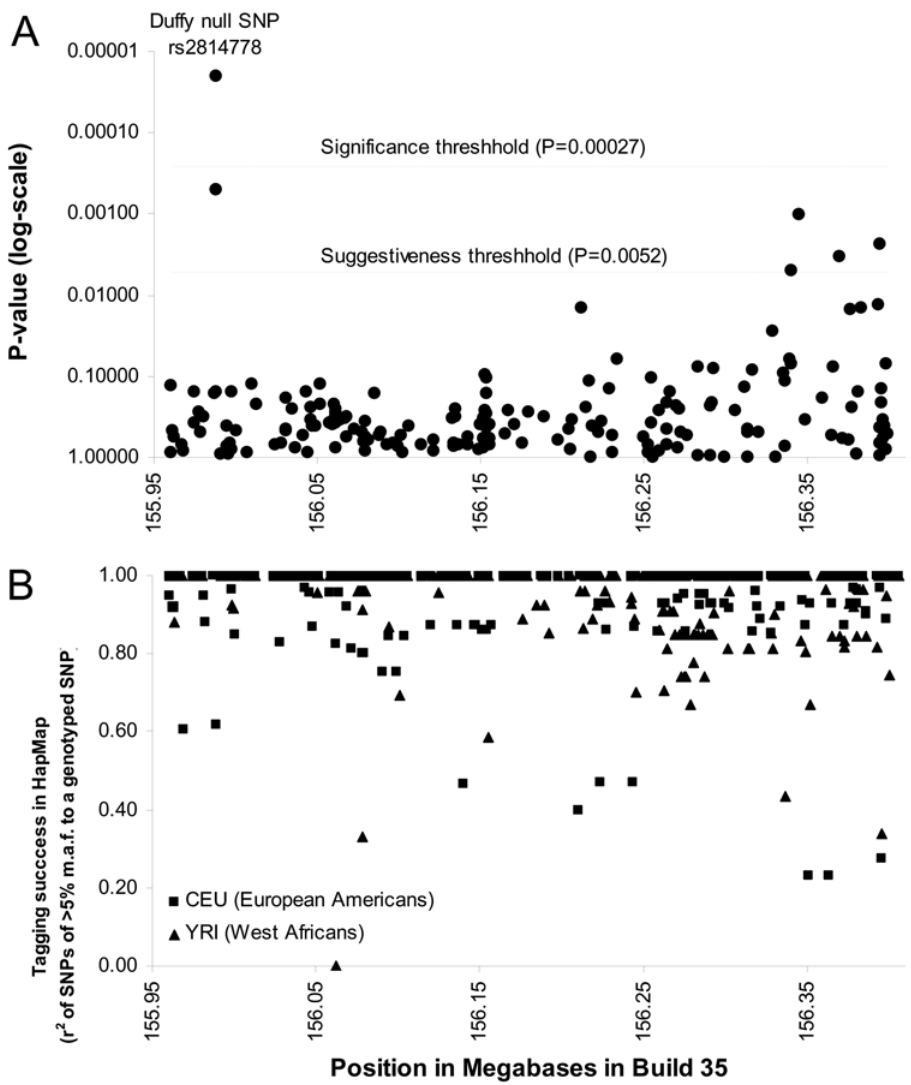
Figure 3. Fine mapping reveals rs2814778 as the only significant association. (A) Results of case-control association analysis for 193 SNPs genotyped in 148 individuals with low neutrophil count ( , 2,100/mm 3 ), which we compared with 74 controls with high neutrophil count (5,000– 9,000/mm 3 ). All samples were selected to have a confident estimate of all African ancestry at the chromosome 1 locus ( . 99% probability) based on ANCESTRYMAP analysis at flanking markers outside the admixture peak. (B) HapMap SNPs of . 5% minor allele frequency are well captured by this genotyping. We find that 94% of West African SNPs and 96% of European American SNPs are correlated with r 2 . 0.8 to one of the SNPs we